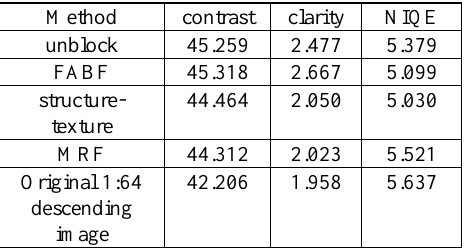
Table 3. Quality metrics of deblocked descent